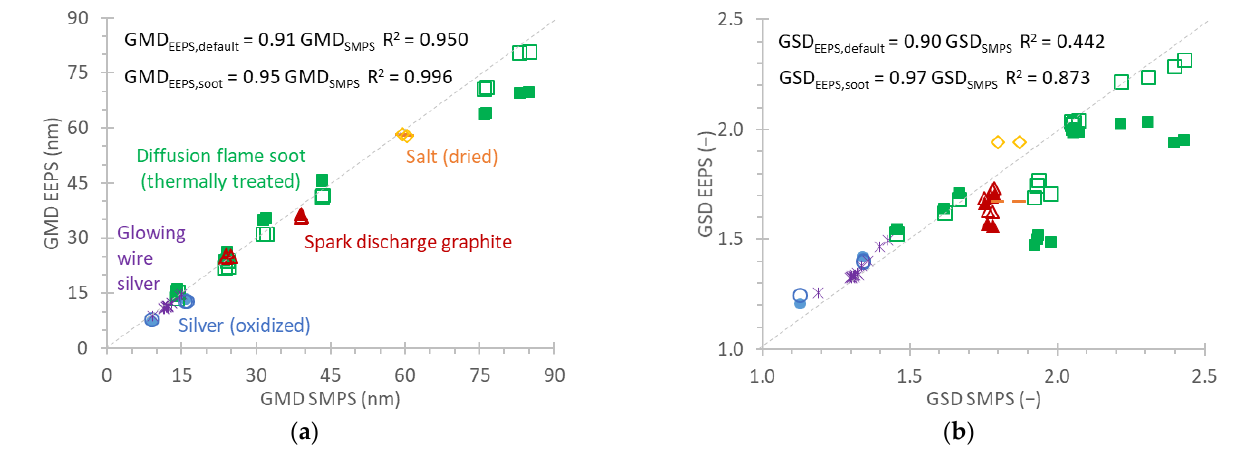
Figure 7. Correlation between EEPS and SMPS: ( a ) geometric mean diameter (GMD); ( b ) geometric standard deviation (GSD). Solid symbols refer to the “Default” EEPS matrix, open symbols refer to the “Soot” EEPS matrix.